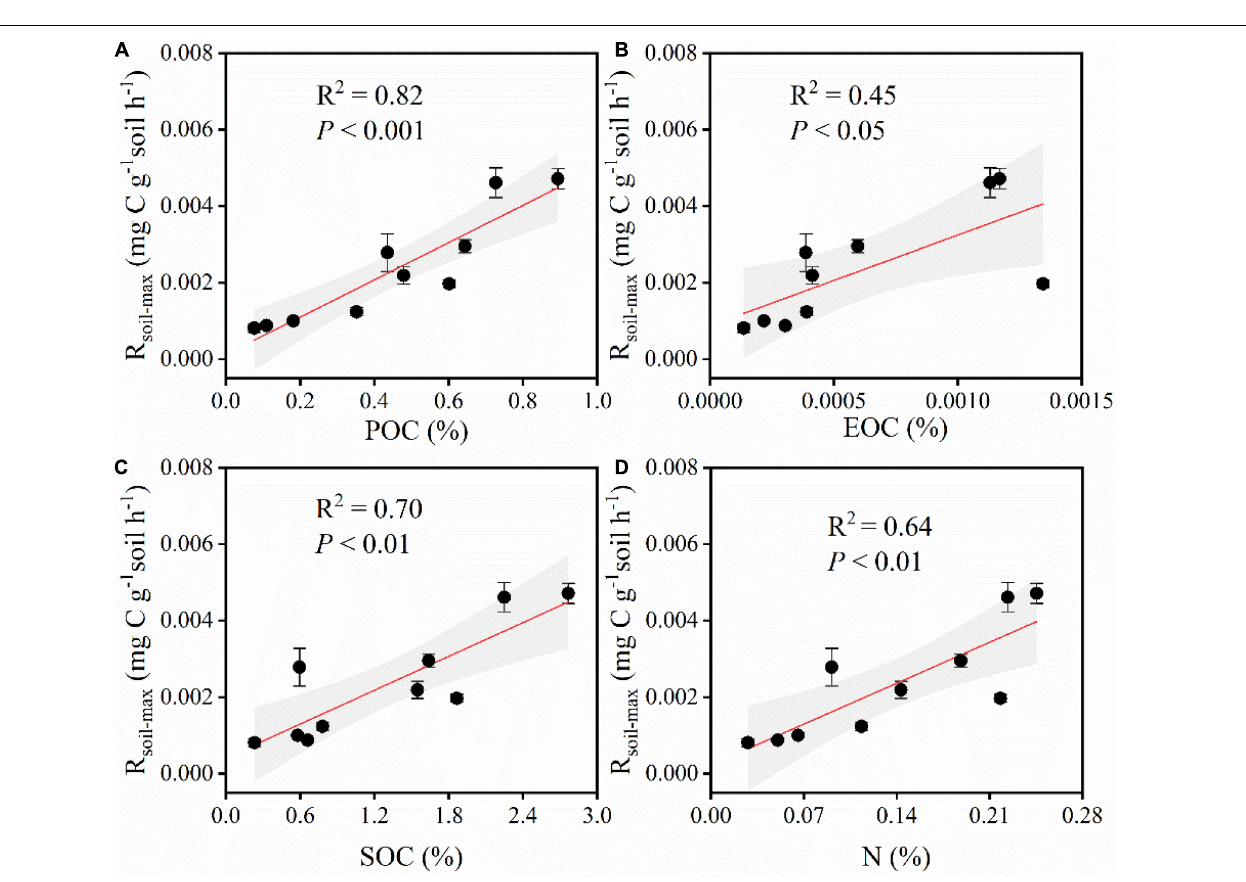
FIGURE 4 | (A) Relationships between R soil − max and POC. R soil − max , soil maximum respiration rate. POC, particulate organic carbon. (B) Relationships between R soil − max and EOC. EOC, easily oxidizable organic carbon. (C) Relationships between R soil − max and SOC. SOC, soil organic carbon. (D) Relationships between R soil − max and N. N, total nitrogen. Shaded areas indicate the 95% confidence interval and vertical bars denote SE.